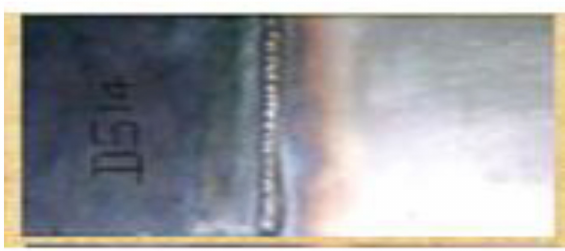
Figure 5. Samples after